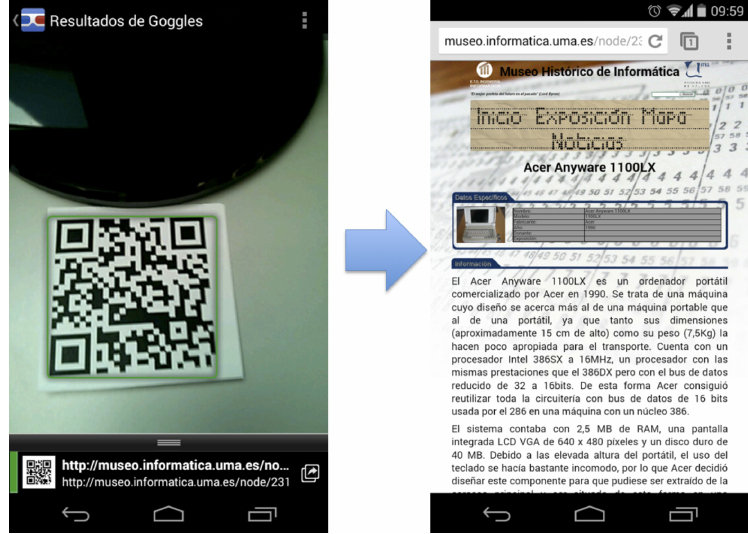
Snapshot of QR tags in exhibits and screen shot of exhibit information in smartphone